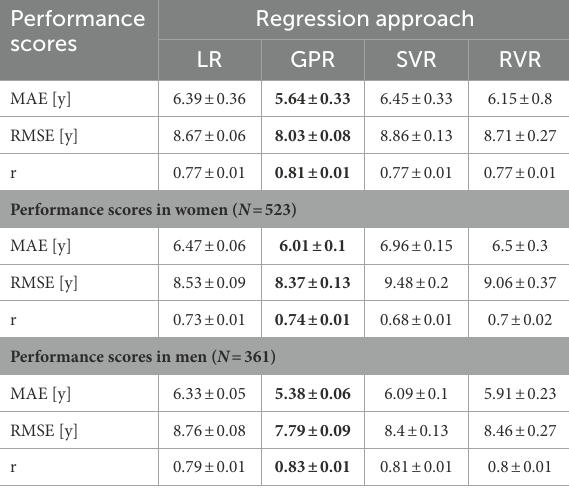
TABLE 4 Performance scores of age prediction after 20 repetitions of cross-validation. Performance